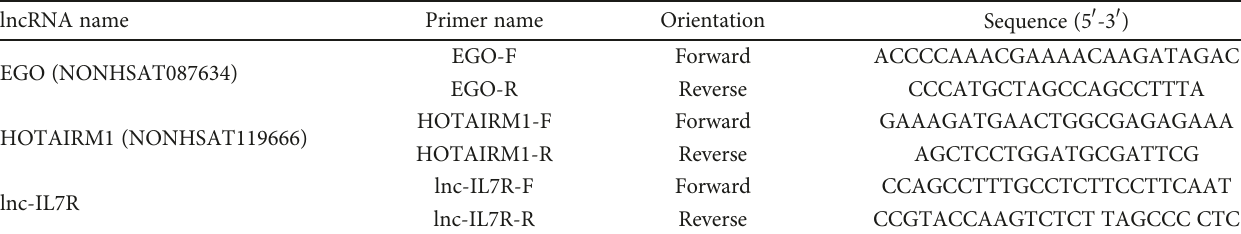
Table 1: List of primer sequences used for